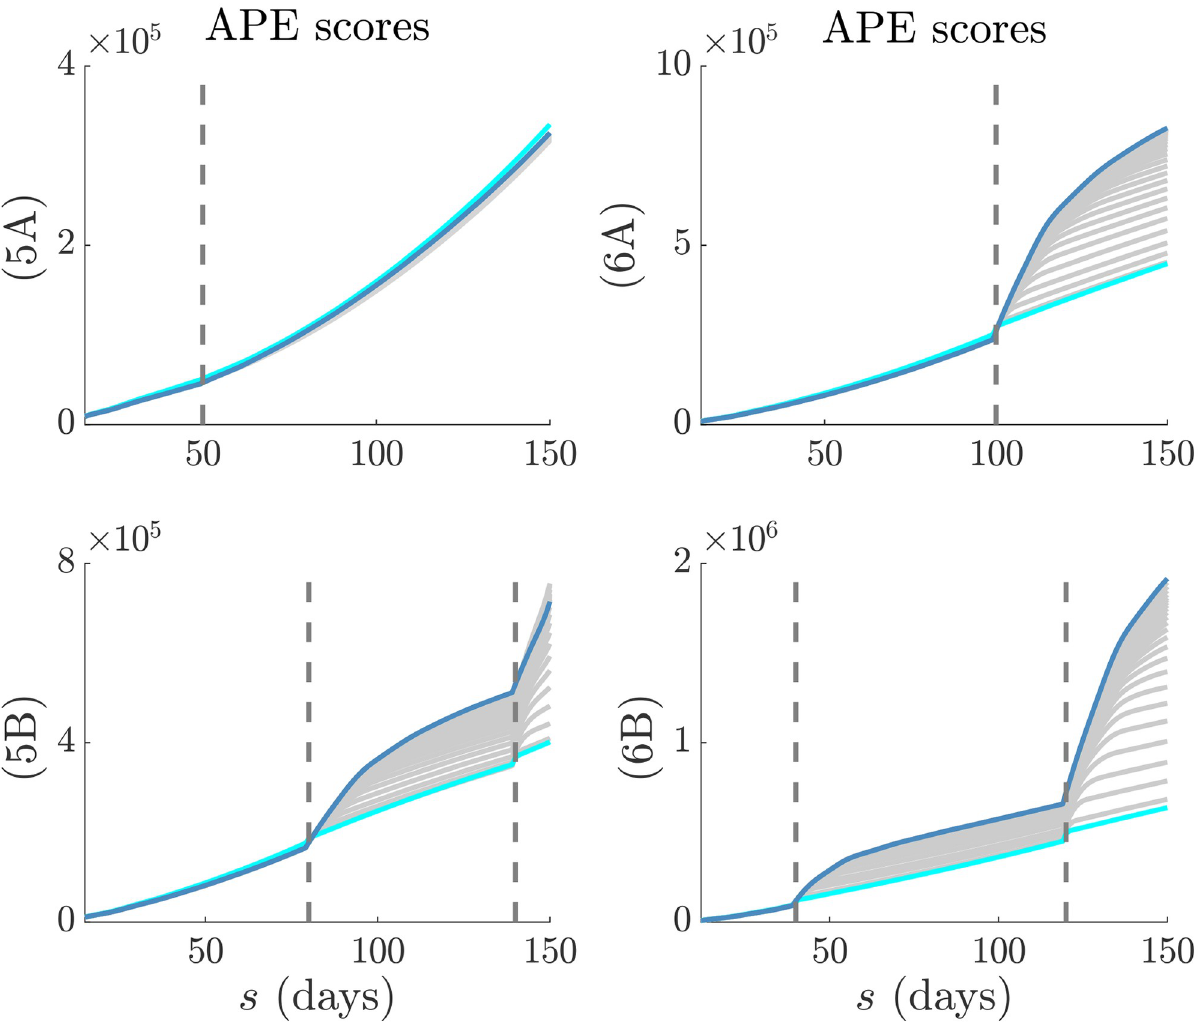
Fig 7. APE scores in real time. The successive (in time) APE scores for each window length, k , are shown in grey. The scores for the smallest and largest k are in cyan and magenta respectively. Graphs correspond to the models in Figs 5 and 6. Dashed lines are the change-times of each model. In (5A) the change-time does not significantly affect the epi-curve shape and so the APE scores are close together. In (5B), (6A) and (6B) the change-times notably alter the epi-curve shape so that the choice of k becomes critical to